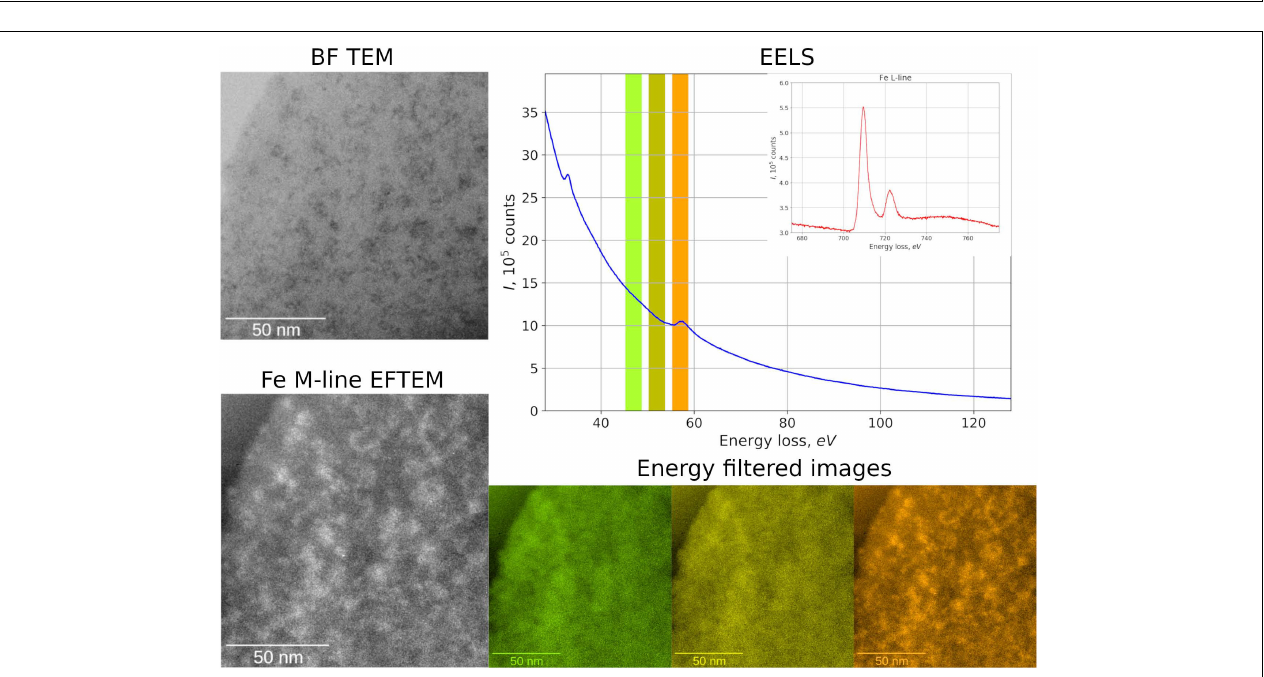
FIGURE 1 | TEM images and size statistics for the three 57 Fe-nanofertilizer samples under study: (a) F, (b) M, (c) S.